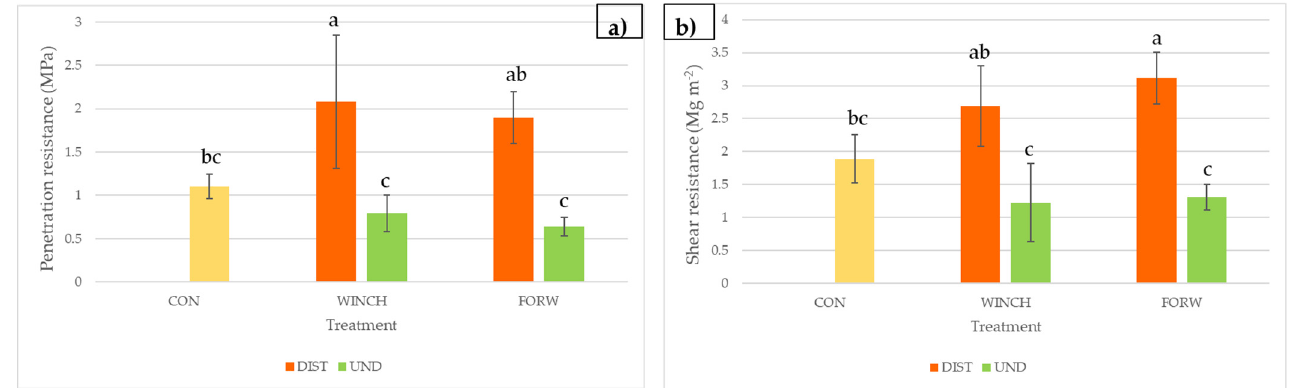
Figure 4. PR ( a ) and SR ( b ) for the different treatments. Different letters indicate different homogeneous group according to an HSD Tukey test ( p < 0.05): CON: control area; WINCH: winching; FORW: forwarding; DIST: soil directly affected by machineries’ passage; UND: soil in the harvested parcels but not directly affected by machineries’ passage.